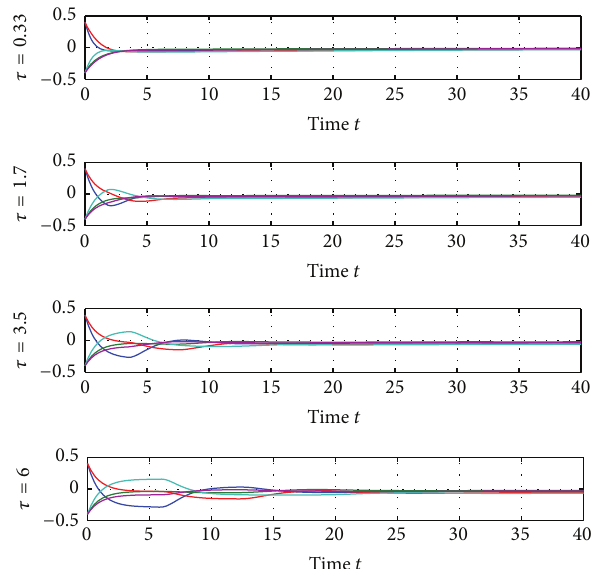
Figure 1: Time histories of system (7) when 𝑛 = 5 (Example 1).